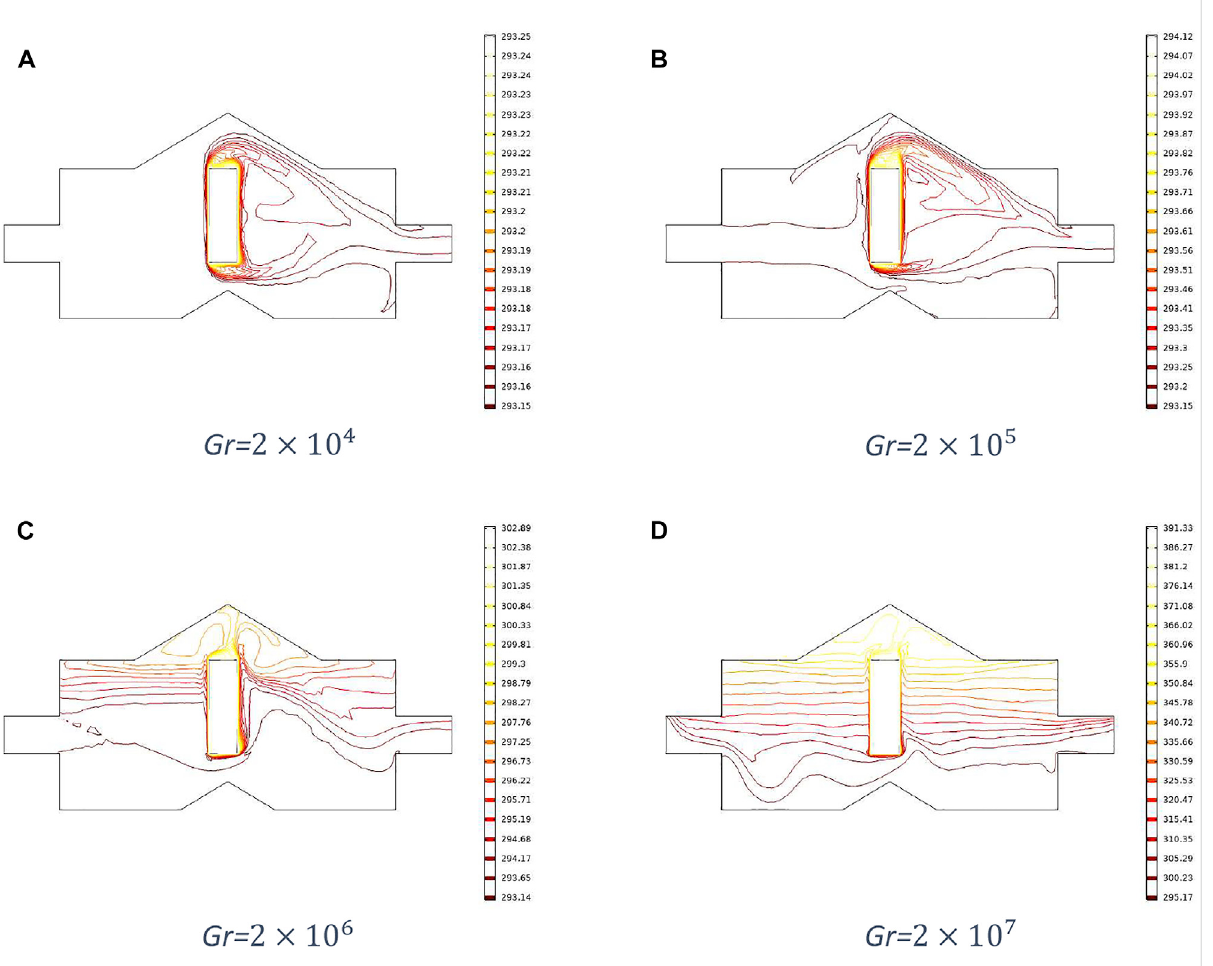
FIGURE 10 Isothermal contours at Re = 1,000 and at different Grashof